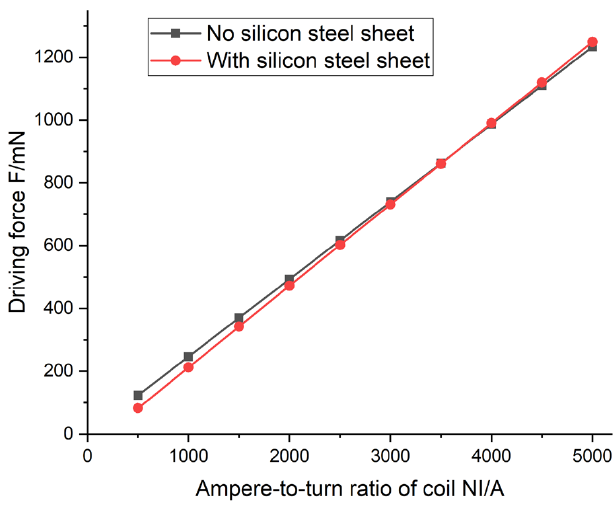
Table 3. Parameters of the array.